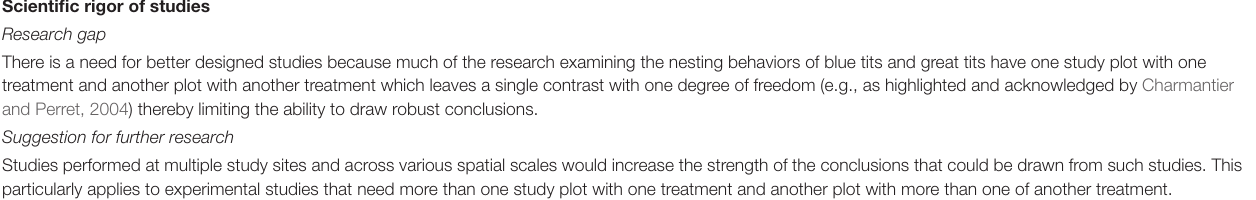
TABLE 1 | Gaps in the research examining the location and design of blue tit and great tit nests and some suggestions for further research. Scientific rigor of